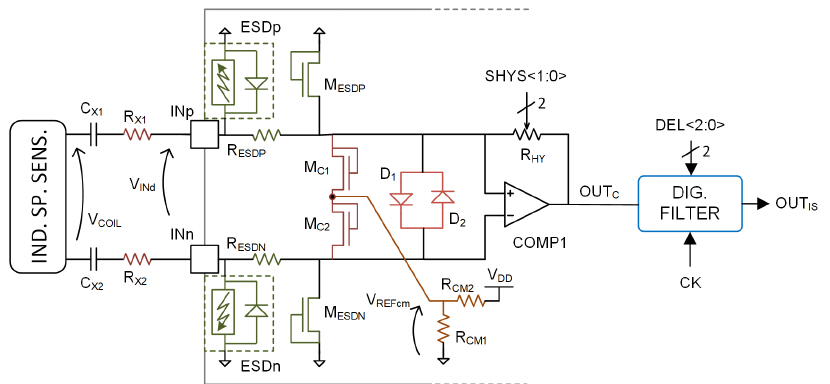
Figure 9. Interface and readout circuit for phonic-wheel inductive